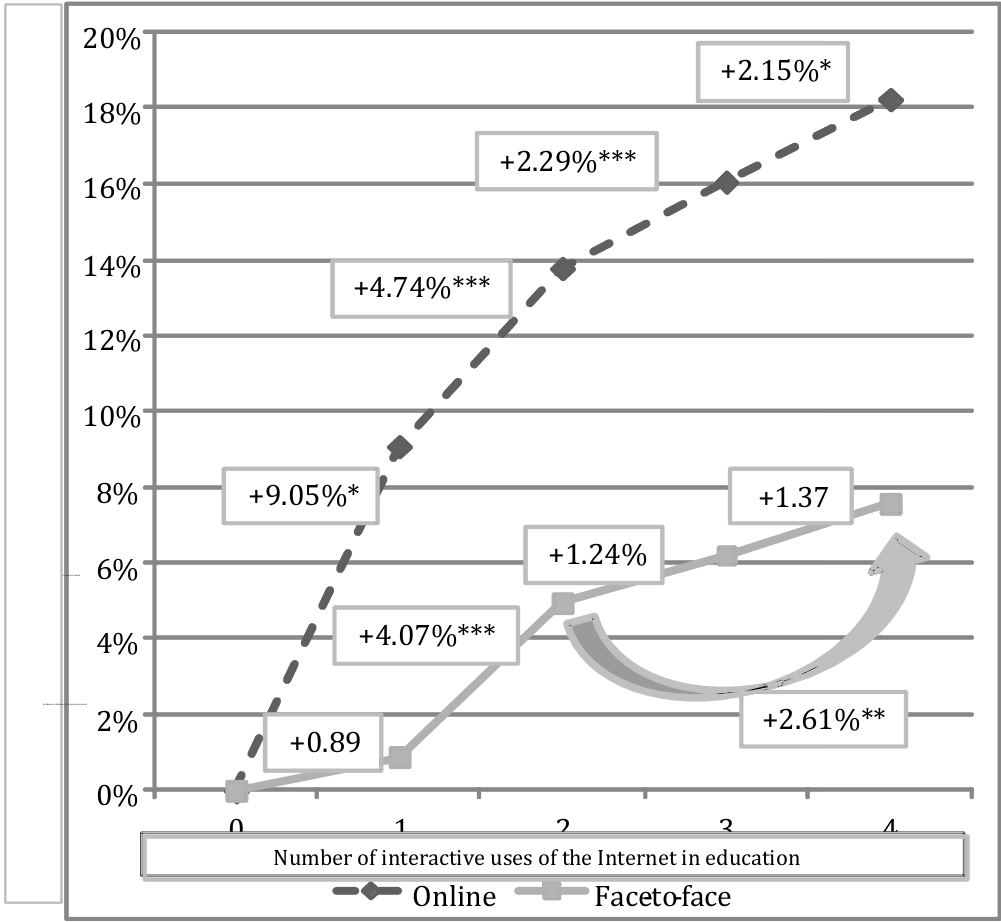
Figure 2 . Total and marginal productivity of interactive uses of the Internet in education, by study mode (graphic representation). ***Significant effect at 99% **Significant effect at 95% *Significant effect at